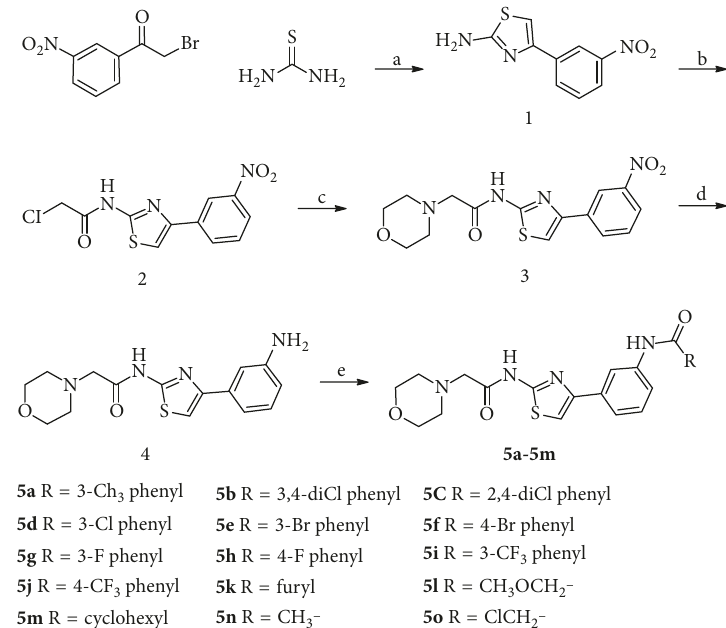
Scheme 1: General synthesis of the target compounds.